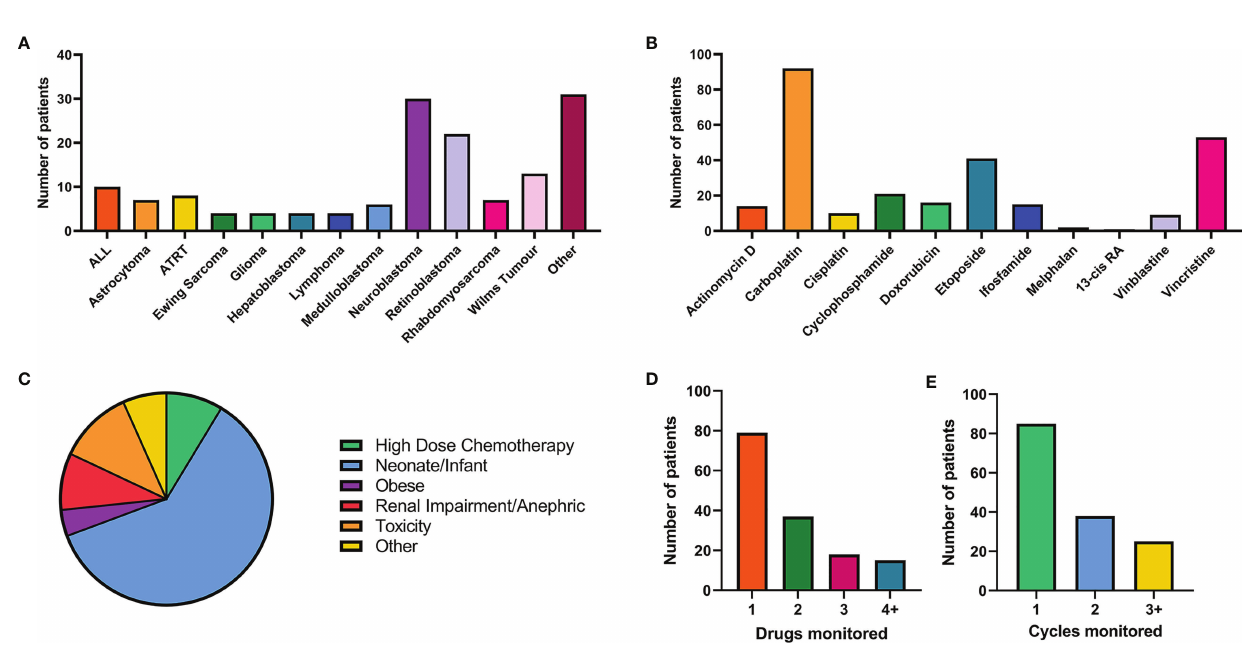
FIGURE 1 | Summary of patient recruitment for the fi rst 150 patient recruited on to the NCCPG TDM 2018 study. (A) Breakdown of tumour types and number of patients (cut off level for each tumour type of 3 patients). (B) Number of patients receiving each chemotherapeutic agent of interest. (C) Patient recruitment by hard-to-treat group. (D) The number of drugs monitored for each patient. (E) Number of cycles of chemotherapy monitored using TDM for each